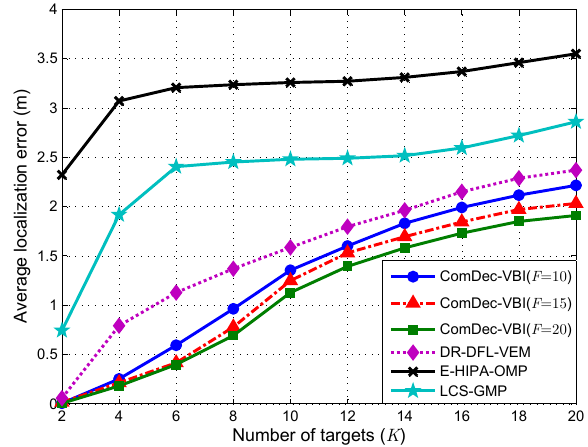
Figure 13. Average localization error with different K